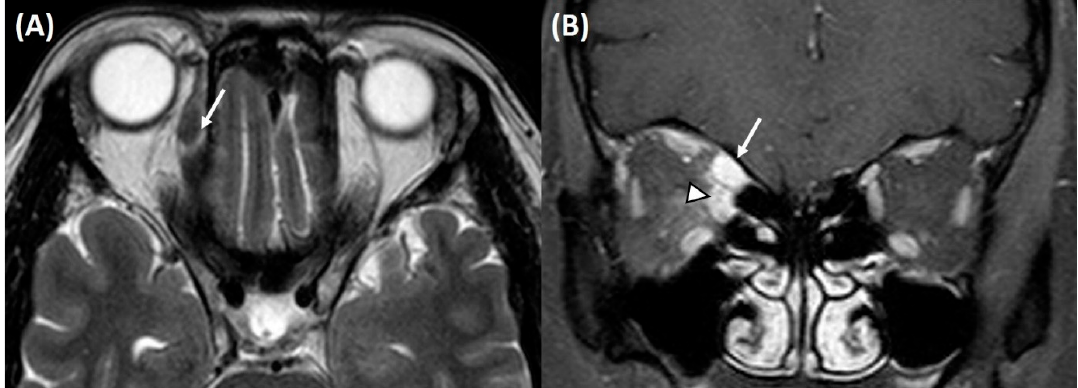
Figure 1. ( A ) T2-weighted axial and ( B ) T1-weighted coronal magnetic resonance imaging with gadolinium contrast shows enlargement and contrast enhancement of the right superior oblique (white arrow) and medial rectus muscles (white arrowhead).